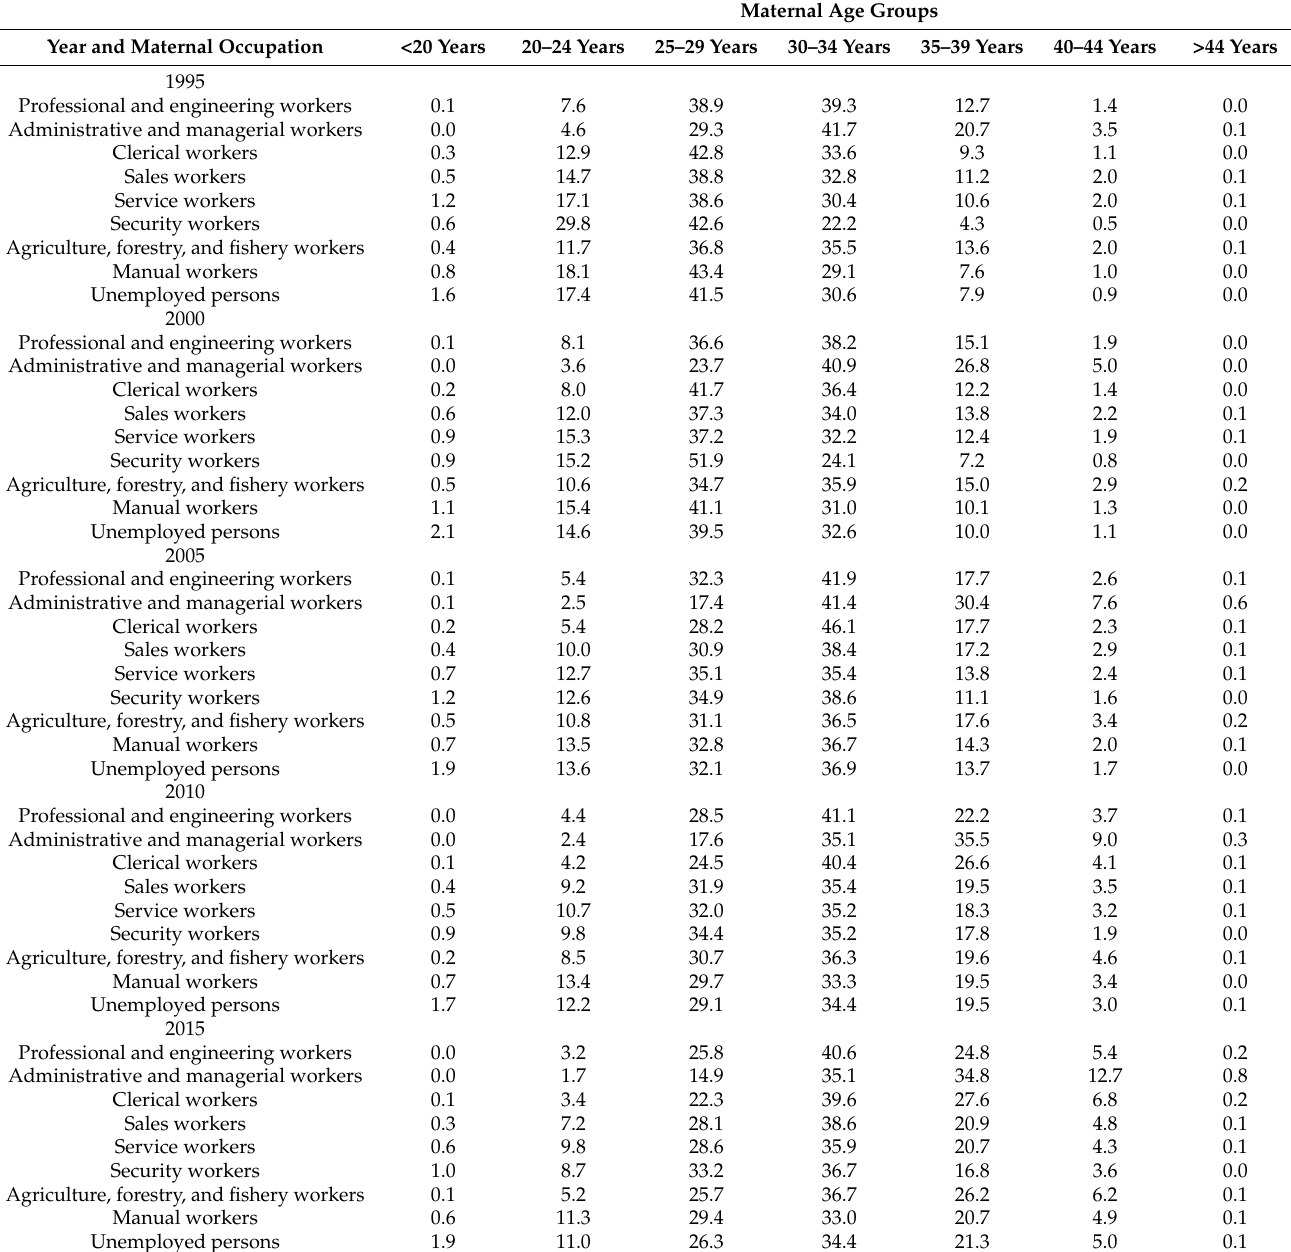
Table 2 shows percentage of number of births for each maternal age within total number of births for each year and maternal occupation. The percentage tended to be the largest in 25–29 years or 30–34 years, while distribution of the percentages across maternal ages slightly differed depending on maternal occupations. Percentages in older ages tended to be large in administrative and managerial workers. Table 2. Percentage of number of births for each maternal age within total number of births for each year and maternal occupation. Maternal Age Groups Year and Maternal